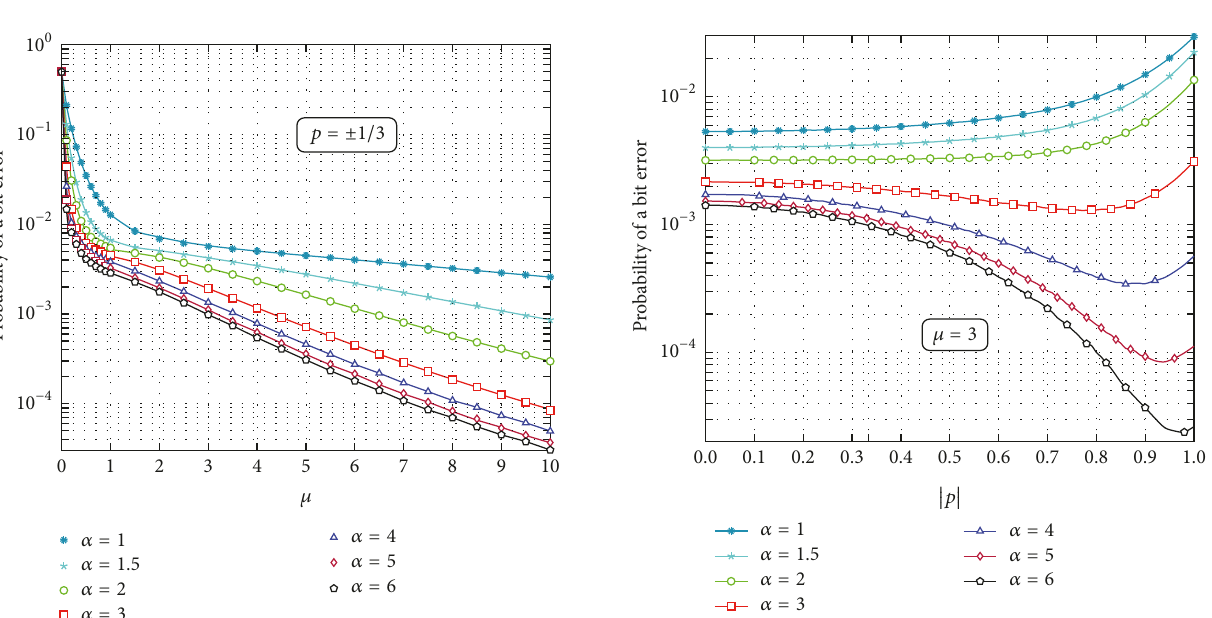
Solid lines: p = 0 Dashed lines: p = ±1/3